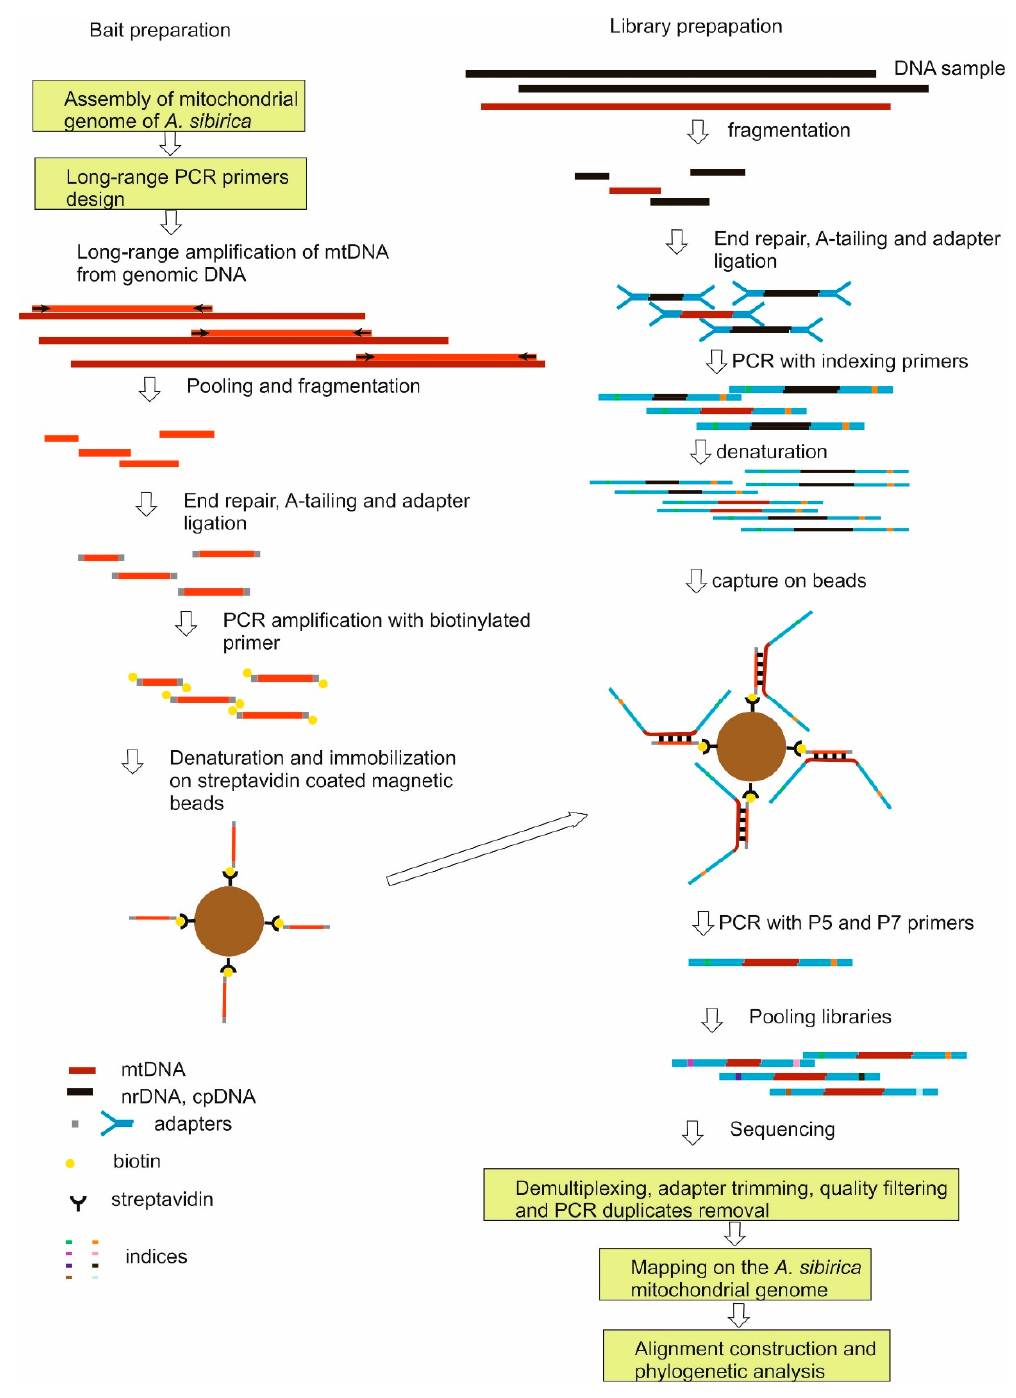
Figure 3. Overview of sequence capture method. The left side shows the preparation of baits, the right side shows the preparation of the indexed library, NGS sequencing of the combined individual libraries, bioinformatics analysis of the sequencing results. Genomic DNA is shown in black and dark red (mtDNA), bytes in light red, adapters and PCR primers in gray and cyan, indices in other colors.